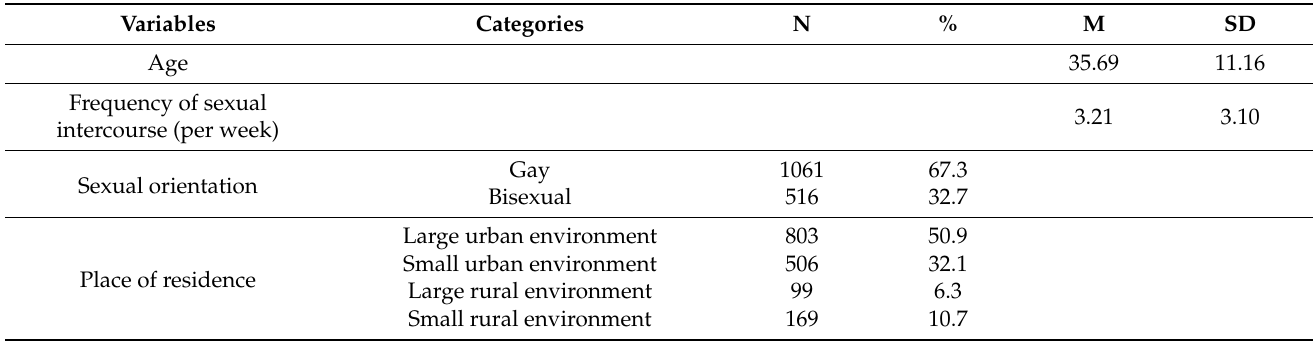
Table 1. Sociodemographic Characteristics of the Sample Participants (N =